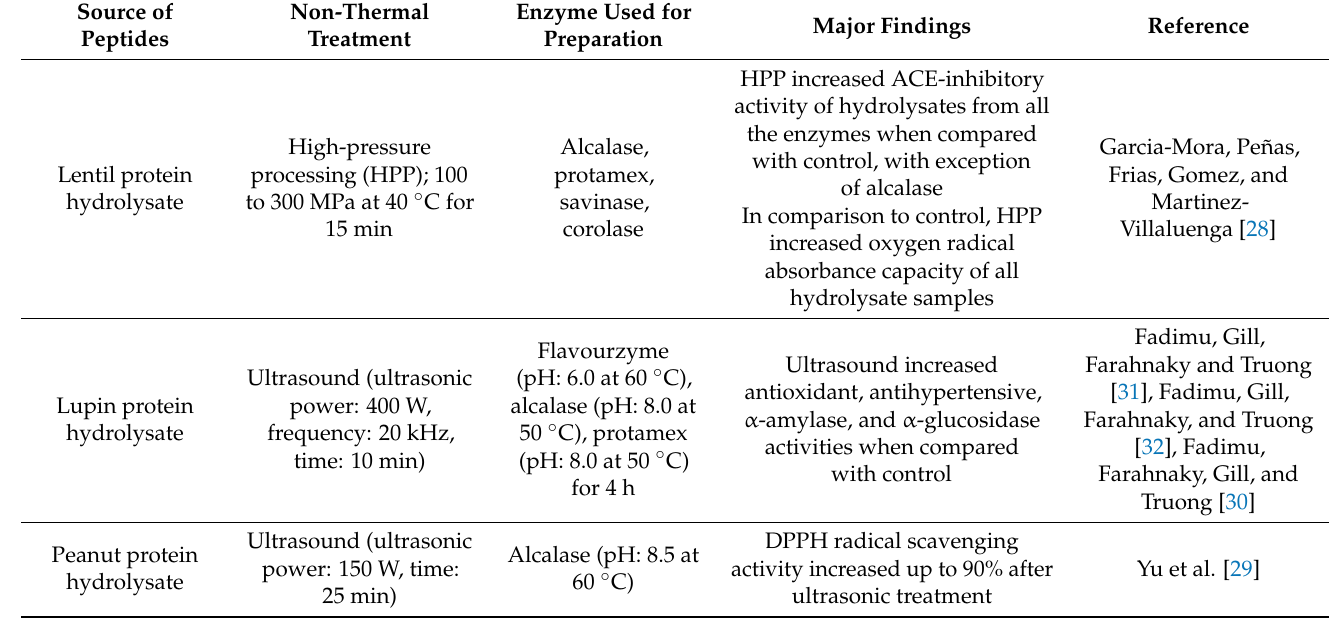
Table 4. Impact of different non-thermal treatments on biological activities of peptides derived from food